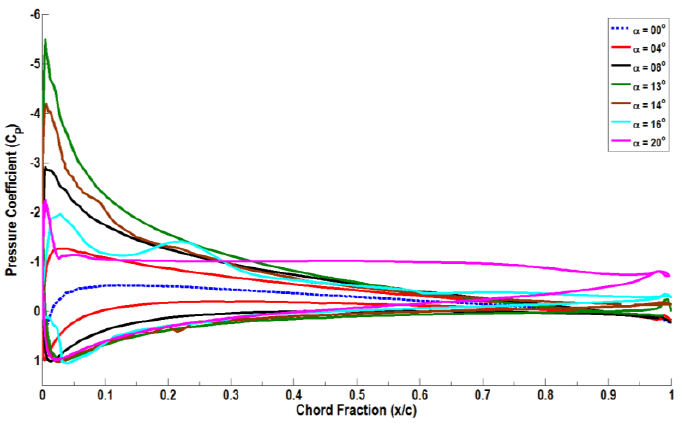
Figure 8. Pressure coefficient curves along the upper and lower surfaces of the airfoil with 0° flap deflection for different incidence at Re = 10 6 .